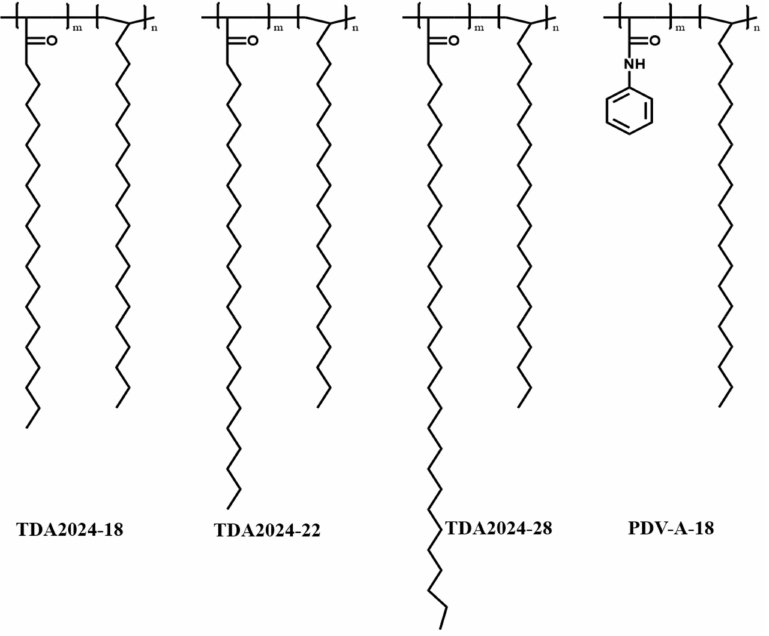
Figure 1. Chemical structures of α -olefins/long alkyl acrylate bipolymers and PDV-A-18. Chemical structure characterization of synthesized bipolymers. The chemical structure of synthesized bipolymers was characterized by Fourier transform infrared (FTIR) and 1 H nuclear magnetic resonance ( 1 H NMR) approaches. The FT-IR was performed by Nicolet 6700FT IR spectrometer with KBr pellet applied for all samples [1]. H NMR spectra were collected by AVANCE 400Hz NMR spectrometer with CDCl 3 as the